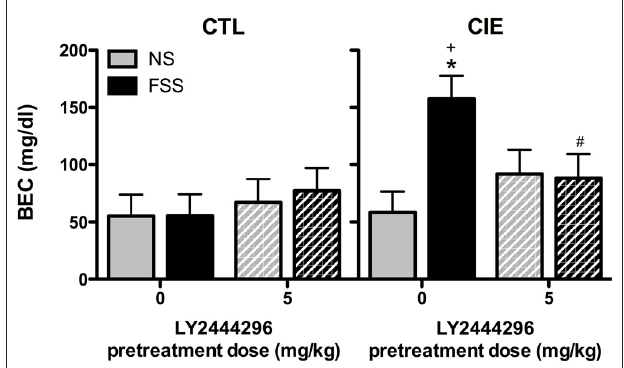
FIGURE 4 | Blood ethanol concentrations (BECs) following the final drinking session. Vehicle-treated CIE-FSS mice had higher BECs than CIE-NS mice (indicated by ∗ ) and CTL-FSS mice (indicated by + ). The FSS-induced increase in BEC was blocked by pretreatment with LY2444296, which resulted in significantly lower BECs than vehicle-treated CIE-FSS mice (indicated by # ).